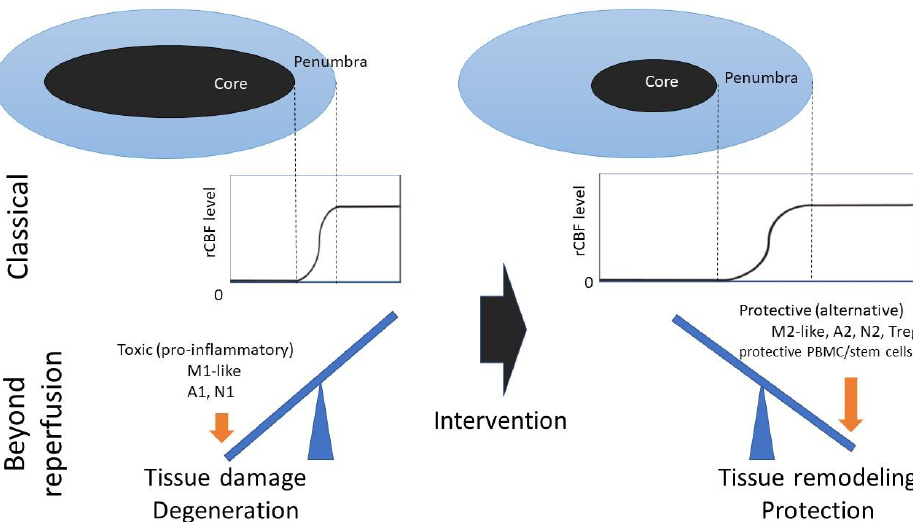
Figure 3. Scheme for polarization strategies. Treg, regulatory T cells. After reperfusion, microglia, astrocytes, neutrophils, regulatory T cells (Treg), PBMCs, M2-like polarized stem cells, A2 astrocytes,